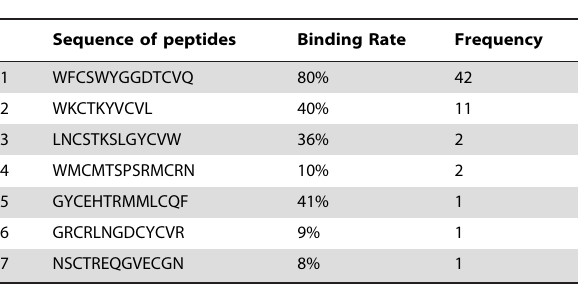
Table 1. Sequences of